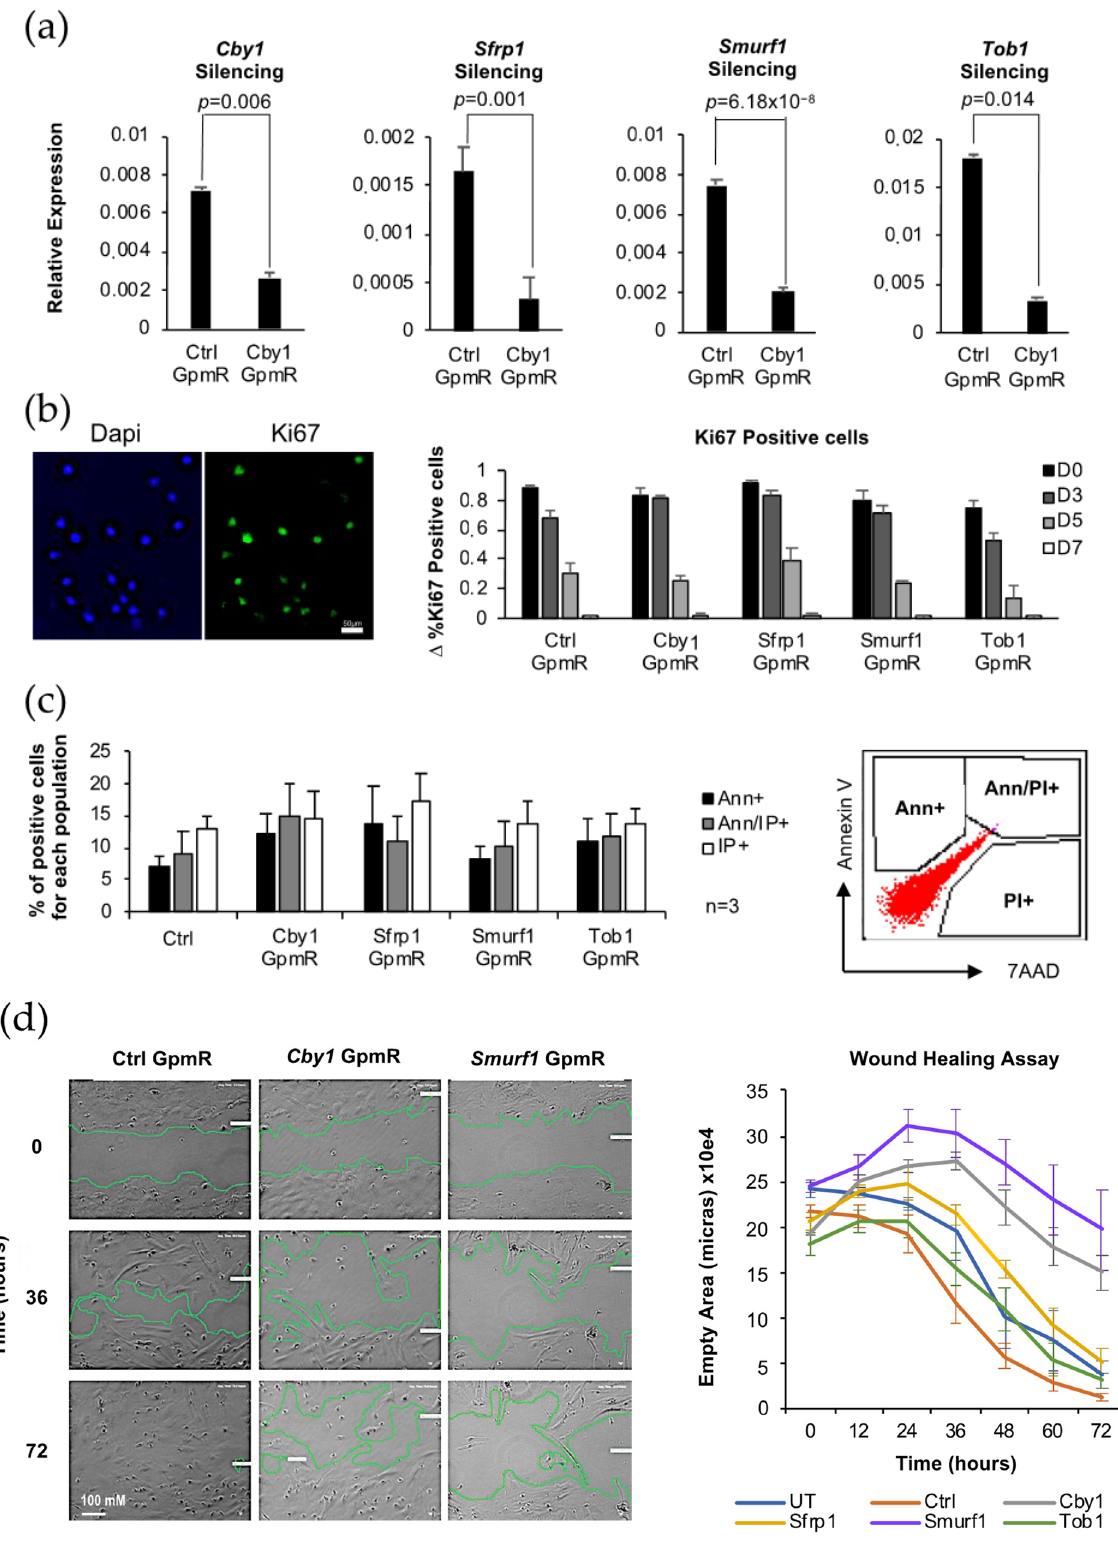
Figure 1. Analysis of proliferation, apoptosis, and migration of MSCs transfected with GapmeRs specific for the silencing of key osteogenic inhibitors. ( a ) Silencing of the different targeted genes in C3H10T1/2 MSCs using specific GapmeRs 48 h after transfection. Ctrl stands for Control GapmeR ( n = 7). Error bars represent standard error of the mean values. ( b ) Representative picture of the immunofluorescence study of Ki67 expression in cells transfected with the different Gap- meRs proliferating in normal culture media at different timepoints. Graph represents the increment of fluorescent cells referred to the previous day in each of the conditions tested. ( c ) Flow cytometry analysis of apoptosis using Annexin V and 7AAD. Average values of three different flow cytometry analysis are shown. Cells were stained with Annexin V (AnnV) and propidium iodide (PI) to detect early apoptosis (Ann+), late apoptosis (Ann/PI+), or dead cells (PI+). Percent- age of positive cells for each population was normalized to cells transfected with the control GapmeR (Ctrl). Flow cytom- etry profile is shown to define populations. ( d ) Wound healing assay. Representative images of cells underperforming in the assay are shown from three independent experiments. Areas lacking cells are outlined. The graph shows the average values and the standard error of at least six different points along the wound measured for each of the samples from a representative experiment. 3.2. Biosafety Evaluation of MSCs Expressing Low Levels of Key Osteogenic Inhibitors An important problem associated with the alteration of the BMP and Wnt/ β -catenin pathways is that those alterations have frequently been found linked to cancer progres- sion and other diseases, highlighting the important role of these pathways in the control of cellular proliferation, invasion, metastasis, and cell death [28–30]. Due to these impli- cations and, since our ultimate goal is the therapeutic use of these cells where the expres- sion of key osteogenic inhibitors has been modified, it is crucial to first check their bi- osafety. To this end, we performed a series of tests aimed to analyze whether processes such as proliferation, migration, and apoptosis of the transfected cells have been altered in a way that could favor tumor formation and progression. 3.3. Effect of Silencing of the Target Genes on Non-Canonical Wnt Pathways Wnt proteins are able to activate the Wnt/ β -catenin canonical pathway that leads to the translocation of β -catenin to the nucleus, but also other pathways that regulate calcium flux and cascades of kinases. One of them, the Wnt/PCP (Planar Cell Polarity) pathway results in the activation of the Jun-N terminal kinase (JNK), which activates c-JUN, the last transcription factor of the pathway. The other non-canonical Wnt pathway, also named the Wnt/PKC (Protein Kinase C) is a Ca 2+ dependent pathway that leads to the release of the intracellular calcium, and thus to the activation of Ca 2+ sensitive enzymes such as PKC [31]. Since in other cell types these other non-canonical pathways have been shown to be activated by the binding of Sfrp1 , we wanted to check whether Sfrp1 inhibition or the in- hibition of Cby1 , also acting in the canonical Wnt pathway, could significantly alter the